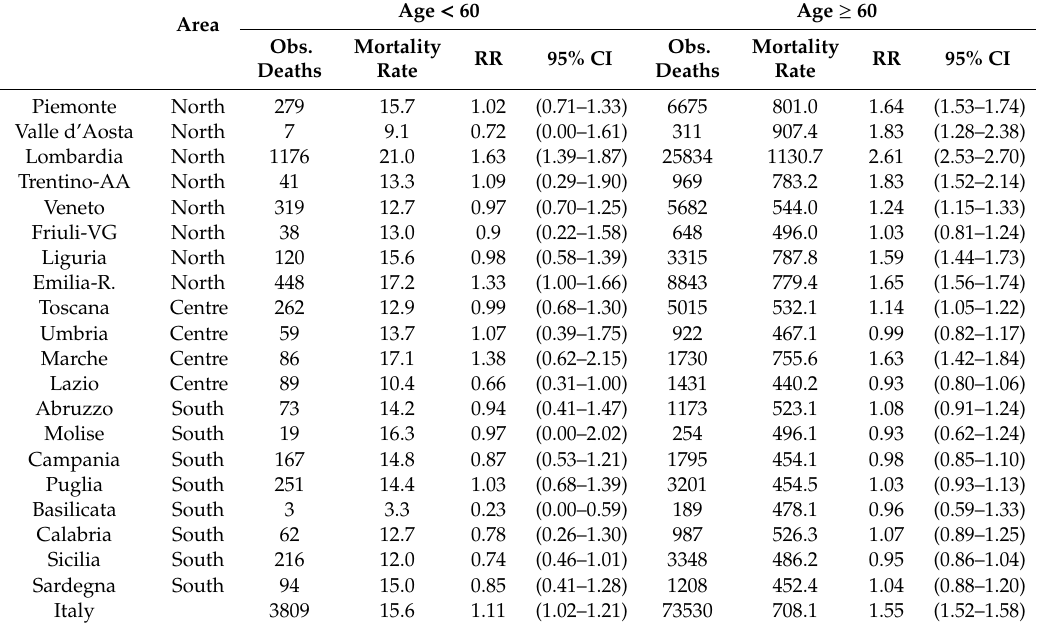
Table 2. Observed (Obs.) deaths, age-adjusted mortality rate per 100,000 (Mortality rate), Rate Ratio (RR) and 95% CIs in the study period from March 1st to April 15th, 2020, in the study municipalities, by region and age class ( < 60 vs. ≥ 60).